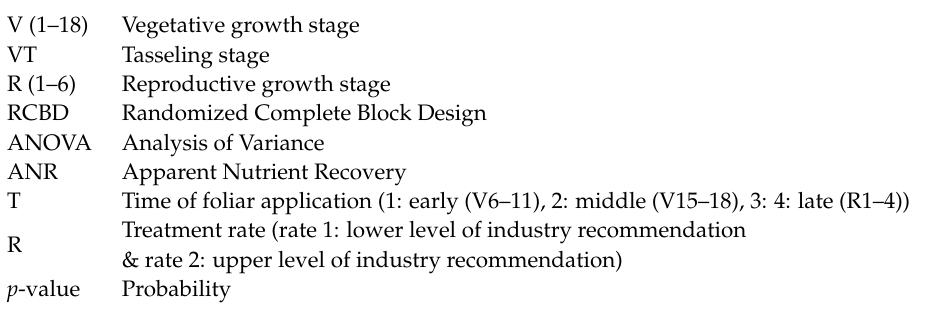
rates and times at different locations., Table S3: Summary location characteristics and results to each foliar micronutrient treatment, Figure S1: Maize growth stages (Ciampitti et al.